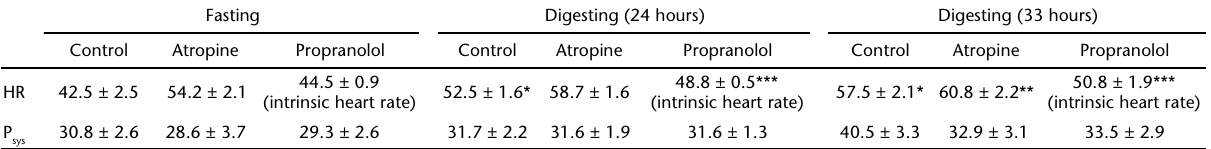
Table 1. Heart rate (bpm) and systemic blood pressure (cm H with atropine and propranolol.